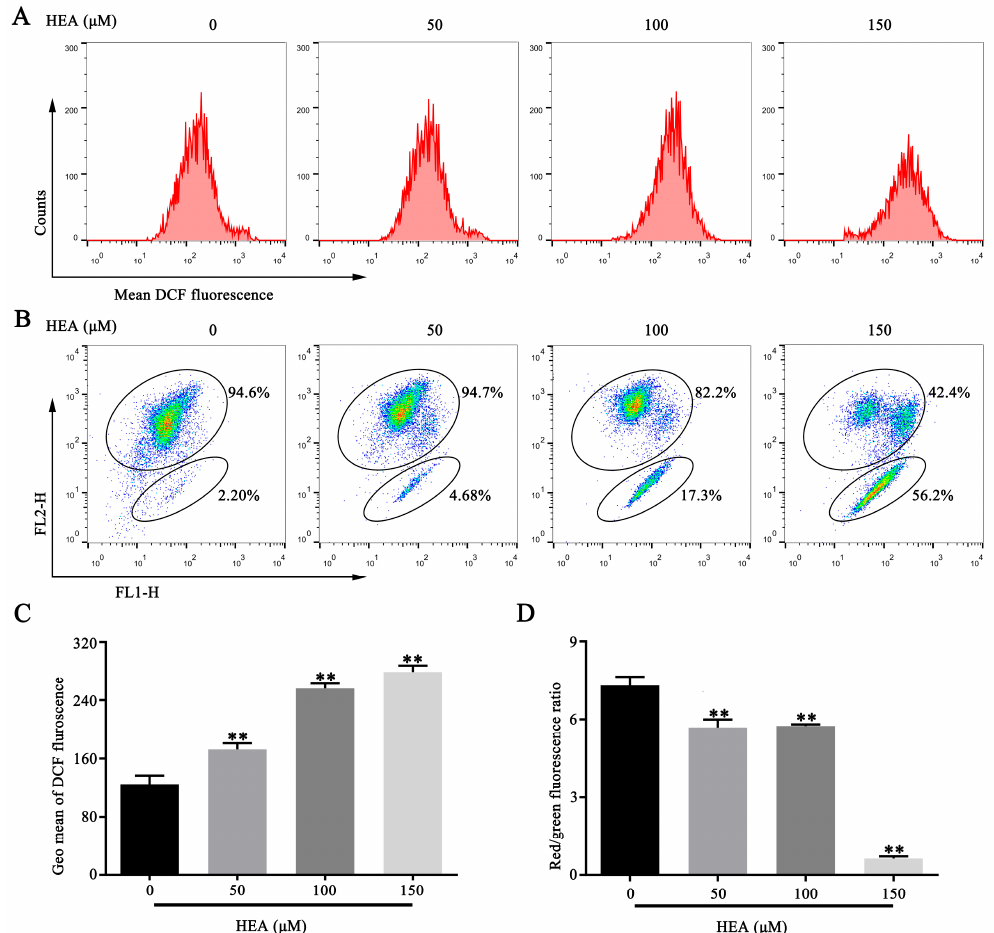
Figure 3. HEA induces ROS production and MMP reduction of SGC-7901 cells. ( A ) After treatment with HEA for 48 h, SGC-7901 cells were stained with ROS indicator (DCF-DA). ( B ) MMP measurement of SGC-7901 cells using JC-1 probe by flow cytometry. ( C ) Quantitation of average DCF fluorescence, indicated by Geo Mean. ( D ) Histograms of average fluorescence intensity. ** p < 0.01 compared with 0 µ M HEA group, three repeats per